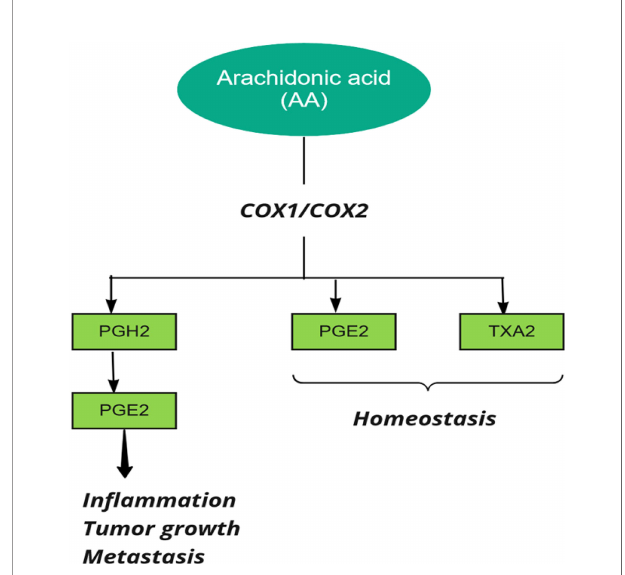
FIGURE 3 | Cyclooxygenase (COX) in metabolism of Arachidonic Acid (AA). PG, Prostaglandin, TX,